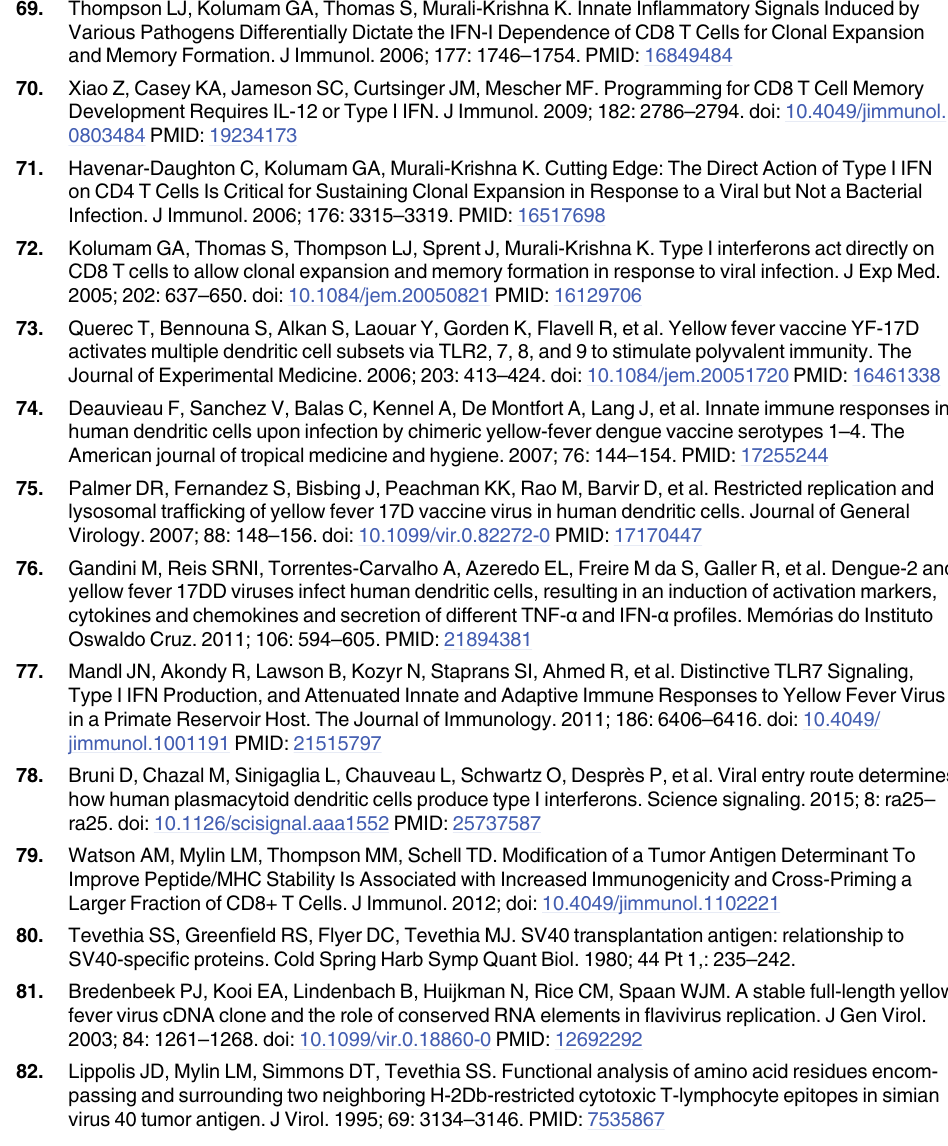
PLOS Pathogens | DOI:10.1371/journal.ppat.1005786 July 27,